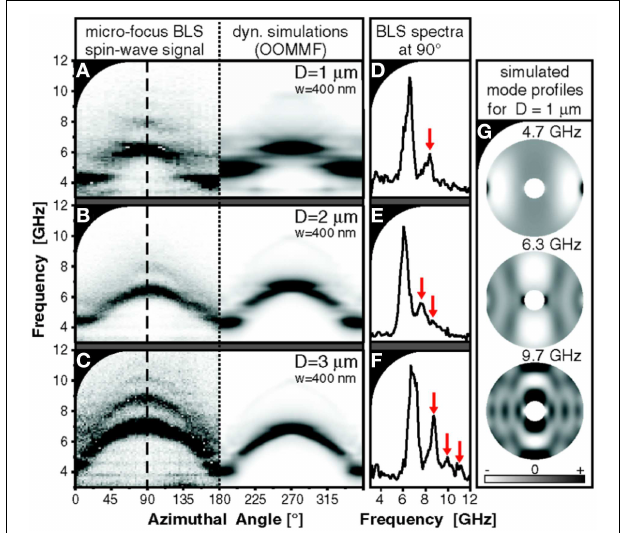
FIGURE 6 | Spin waves in Ni 81 Fe 19 rings with diameters ranging from 1–3 µ m and a width of 400nm. Taken from Schultheiss et al. [72]. (A–C) Experimentally observed (left side) as well as simulated (right side) intensity profiles of the spin-wave modes. The azimuthal angle indicates the position along the ring’s perimeter. (D–F) Individual BLS spectra for fixed position. (G) Simulated mode profiles for different spin-wave modes at a ring with diameter D = 1 µ